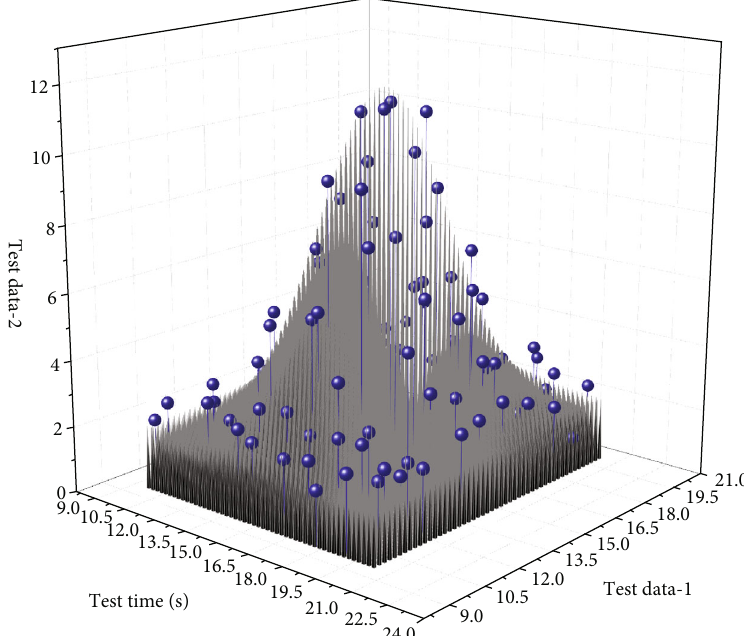
Figure 7: School labor education practice